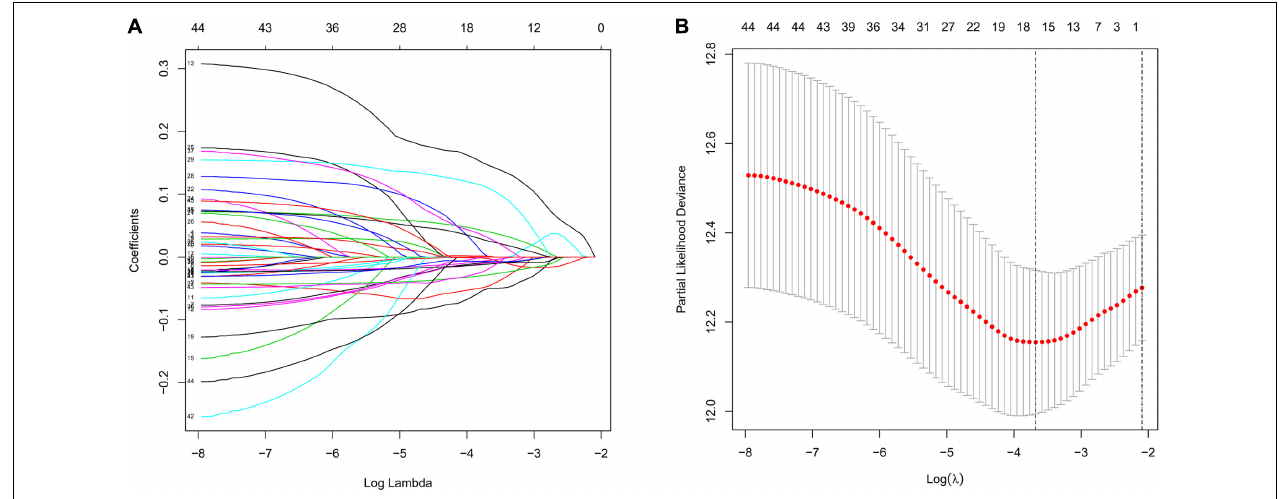
FIGURE 4 | Establishment of prognostic risk model by LASSO regression analysis. (A) LASSO coefficient profiles of the 45 prognosis-related genes in TCGA-LUAD. A coefficient profile plot was generated against the log (lambda) sequence; (B) selection of the optimal parameter (lambda) in the LASSO model.